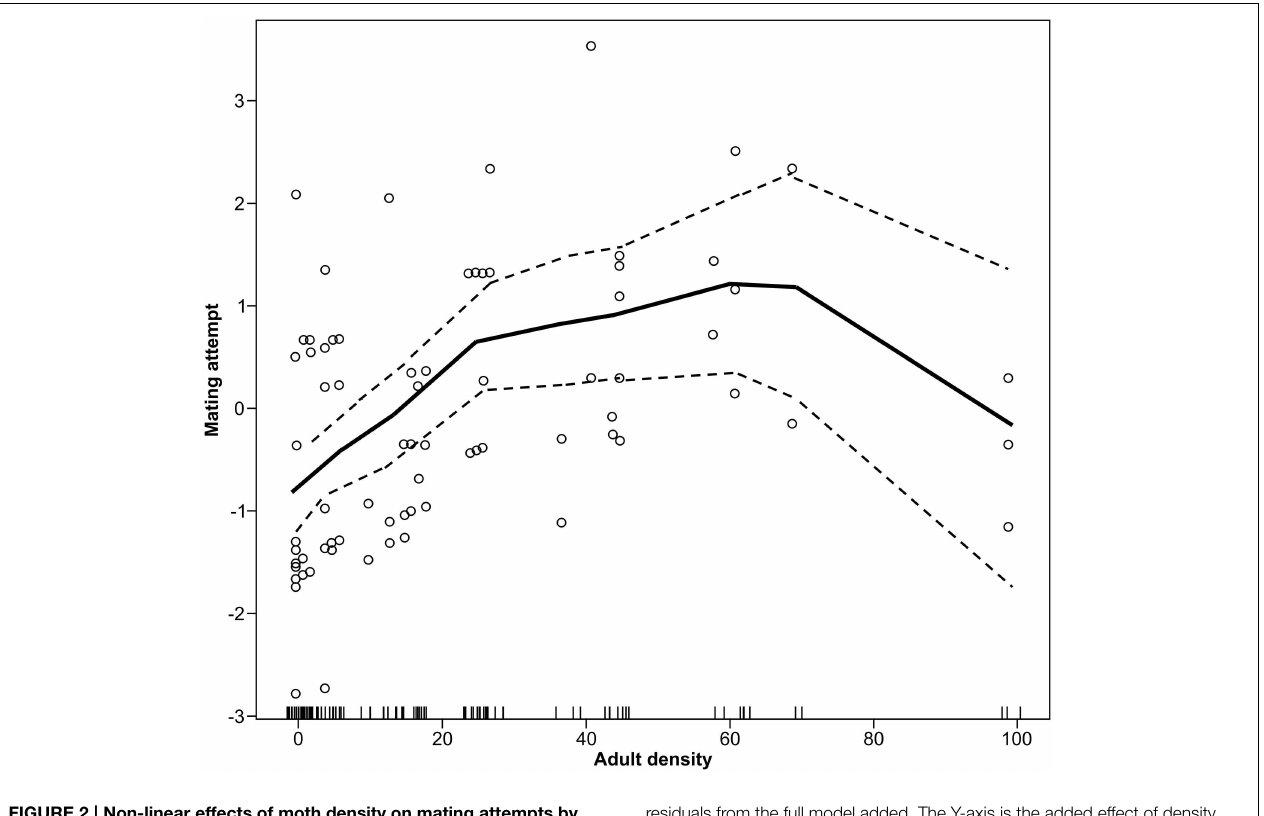
residuals from the full model added. The Y-axis is the added effect of density on mate attraction, with the mean rate of attempts as a logit of the proportion successfully attracted centered on